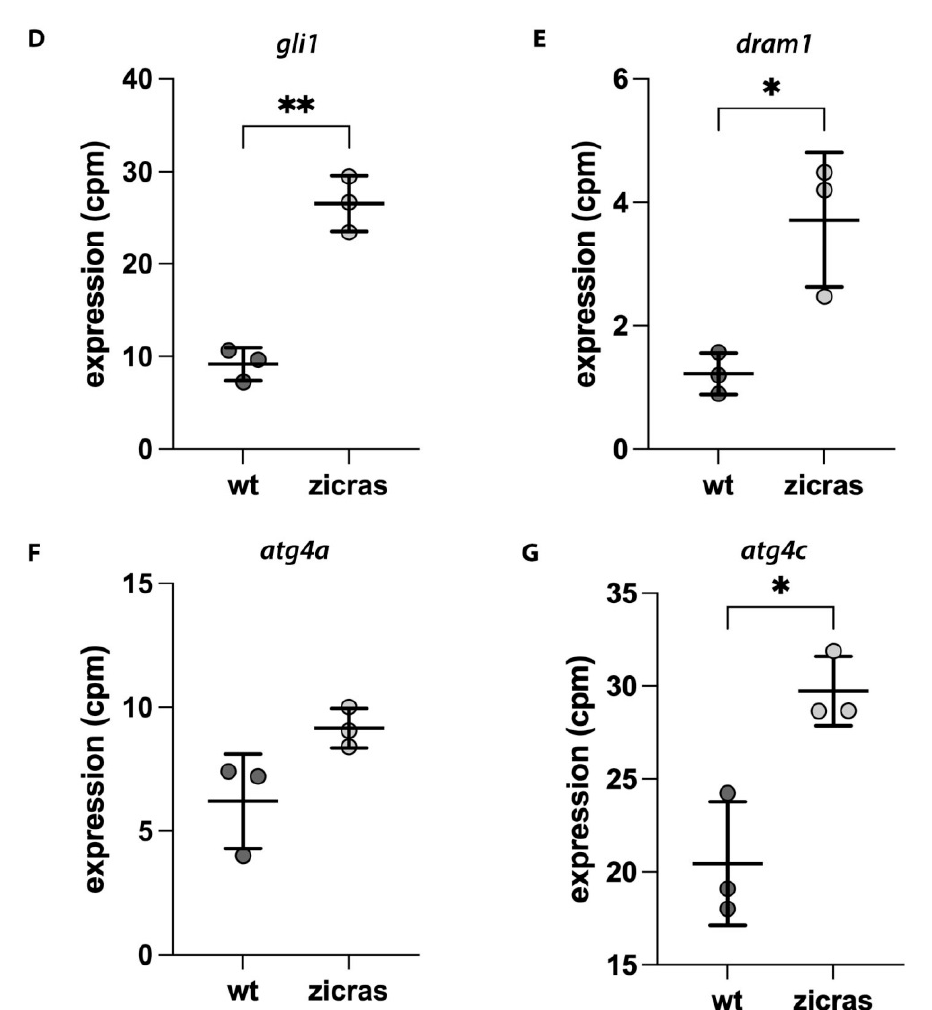
Figure 6. Impairment of the autophagic process in the zebrafish model with Hh hyper activation and in the zicras mutants. ( A , B ) Confocal images of the trunk-tail region of Tg( CMV:eGFPmap1Lc3b ) embryos injected with ( A ) rfp -mRNA or ( B ) shh mRNA. ( C ) Count of the Lc3b puncta of rfp- and shh -mRNA injected embryos. Scale bar indicates 100 µ m. ( D – G ) Expression analyses of ( D ) gli1 and genes involved in autophagy activation, including ( E ) dram1 ; ( F ) atg4a, and ( G ) atg4c, derived from the analyses of wild-type and zicras (tumor) zebrafish brains (GSE74754). Data are presented as mean ± standard deviation. cpm—counts per million. Unpaired t-test with Welch correction. *** p < 0.001; ** p < 0.01; * p < 0.05. Scale bar indicates 100 μ m.